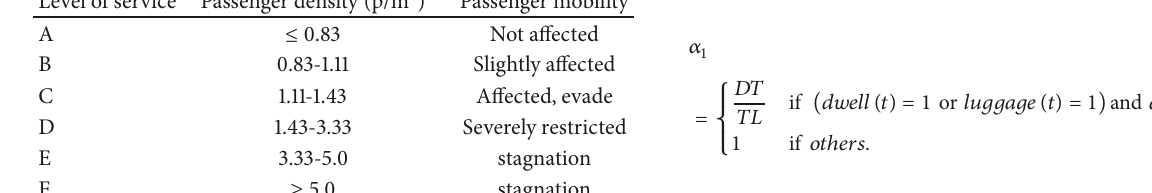
Table 1: Passenger density and mobility at different levels of service. Level of service Passenger density (p/m 2 )